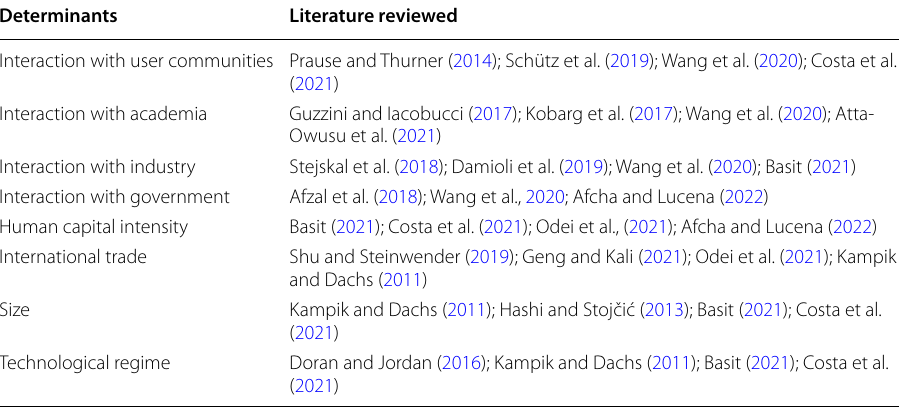
Table 1 Determinants of firms’ innovation performance Determinants Literature